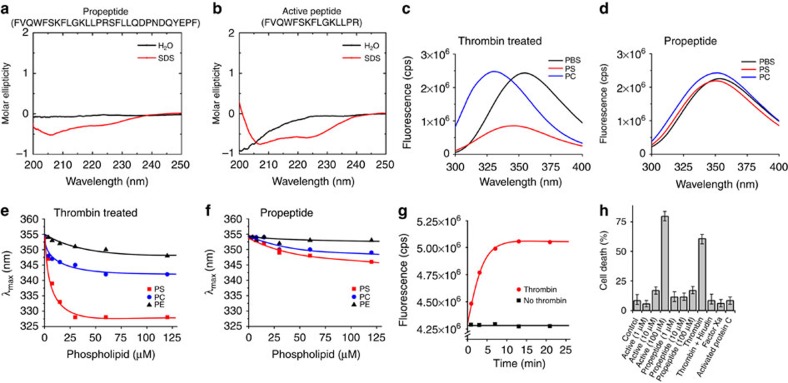
Biophysical and cellular confirmation of RIP technology lacking dye conjugates.(a–d) When incubated with SDS micelles or liposomes consisting of phosphatidylserine (PS) or phosphatidylcholine (PC) thrombin-treated PAR1–RIP inserts into each membrane evident by circular dichroism (a,b) and the decrease in maximum emission wavelength of its tryptophan within the membrane-binding segment. In contrast, the pro-peptide PAR1–RIP undergoes little change in spectra (c,d). (e) Titration of the activated peptide with increasing amount of liposomes reveals a preference for negatively charged PS membranes. (f) Slight changes in maximum emission wavelength and the near-linear response are indicative of limited interaction. (g) Co-incubation of thrombin (10 nM) with PAR1–RIP (8 μM) and PC liposomes (100 μM) demonstrates time-dependent proteolysis and indicated lack of non-specific association of the peptide. (h) Measuring cell viability using Trypan blue uptake reveals a clear difference in cellular effects of the pro-peptide, which is non-toxic, and its thrombin-activated form. Blocking proteolysis with the thrombin-specific inhibitor confirms the role of the protease. Data are mean±s.d. of three biological replicates. cps, counts per second.